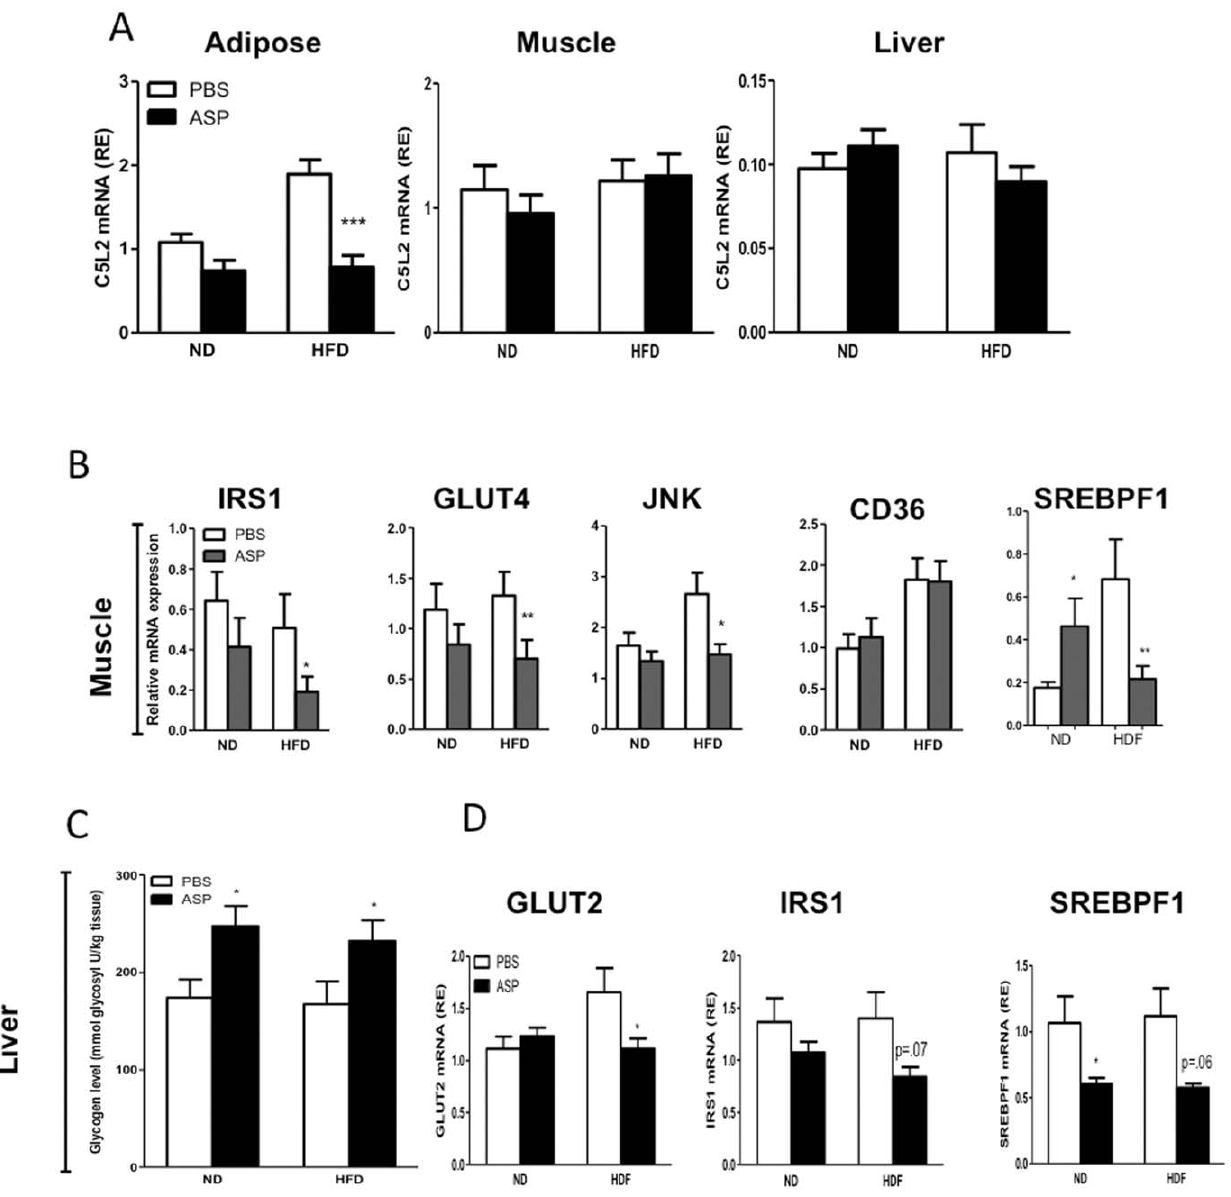
Figure 3. ASP effects on mRNA expression of C5L2 and Insulin-related genes adipose tissue, muscle and liver. A) C5L2 mRNA gene expression in perirenal (left panel), muscle (center panel) and liver (right panel) tissues. B) Gene expression in muscle tissue, C) Liver glycogen levels and D) liver gene expression levels from C3KO or C3KO + ASP mice fed on ND and HFD. Results are presented as average 6 SEM (n=5 2 8), where *p , 0.05, **p , 0.01 and ***p ,